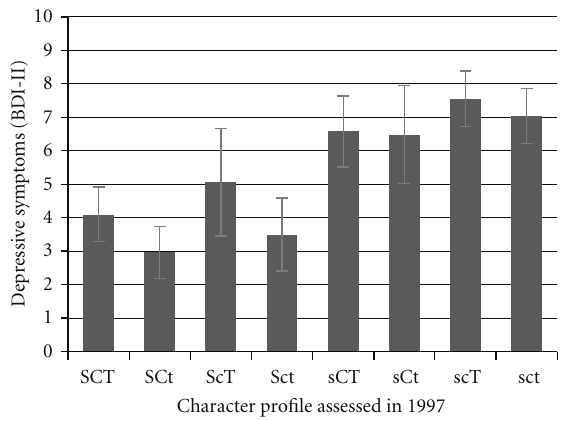
Figure 3: BDI-II depressive symptoms sum scores in di ff erent character combinations. Sex and birth year were controlled. SCT = creative; SCt = organized; ScT = fanatical; Sct = autocratic; sCT = moody; sCt = dependent; scT = disorganized; sct = depressive.